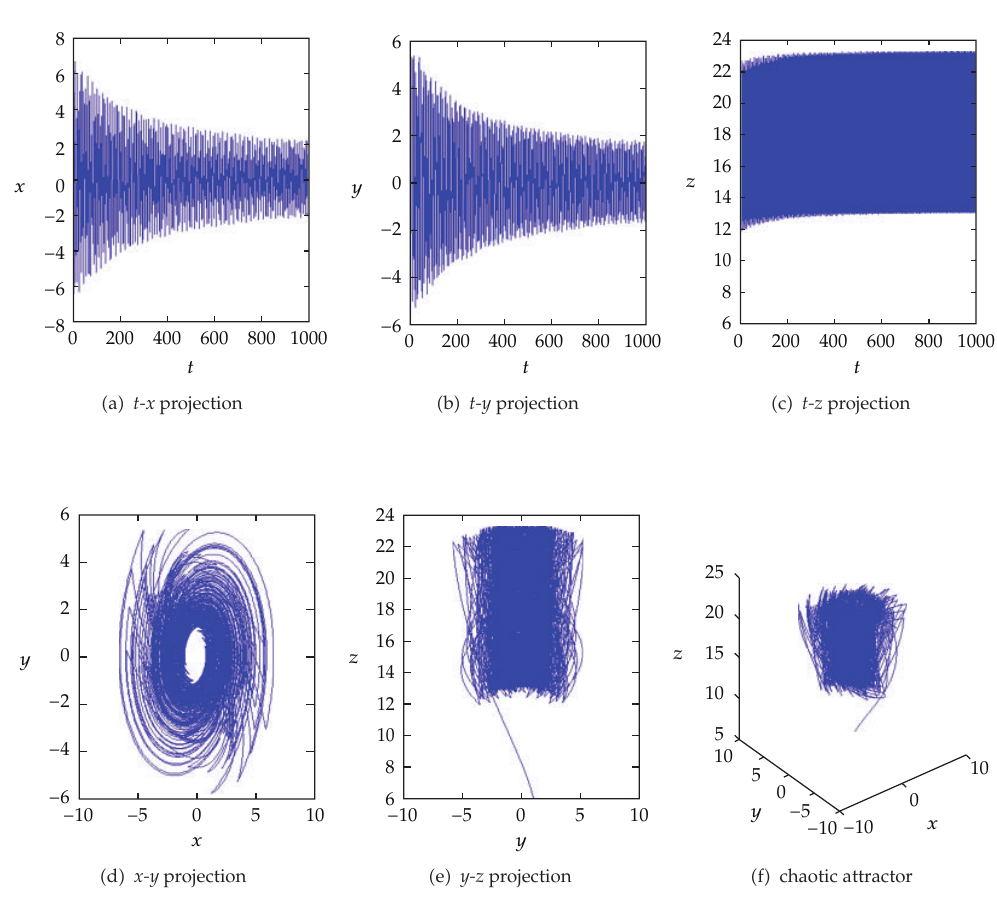
Figure 3: Chaotic attractor generated by three-dimensional space function (cid:4) 3.2 (cid:5) .